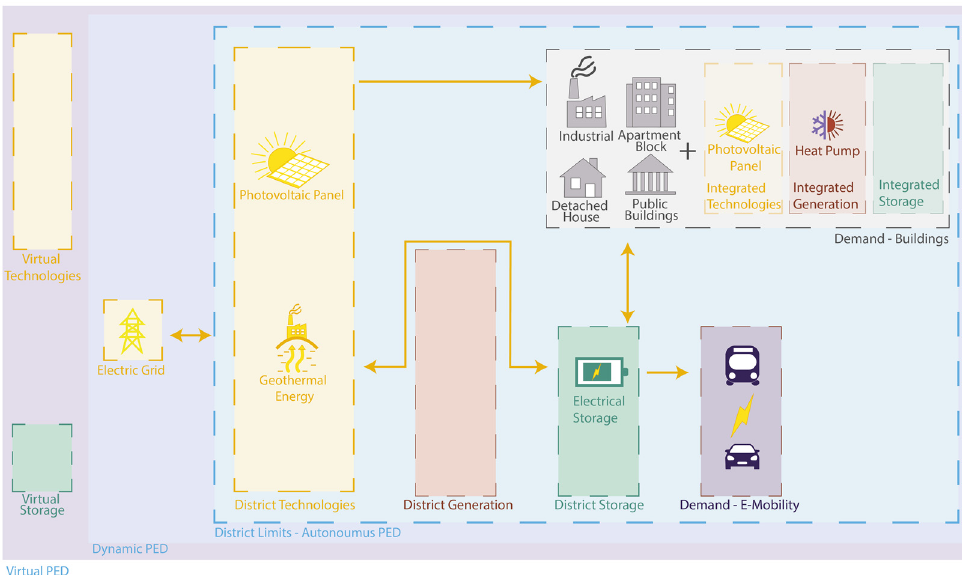
Figure 12. Summary diagrams of the most frequently used technological choices in Mediterranean climate Csa.